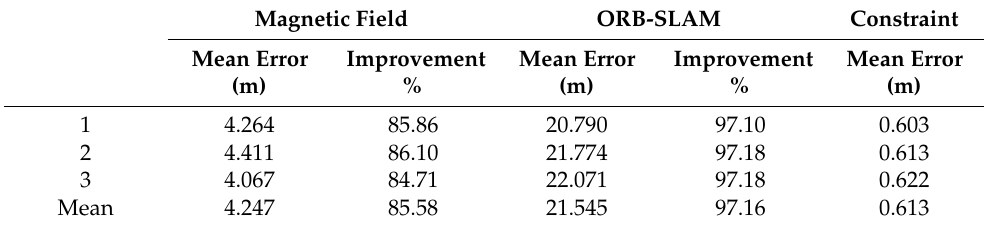
Table 6. Comparison of the positioning results of different methods. Magnetic